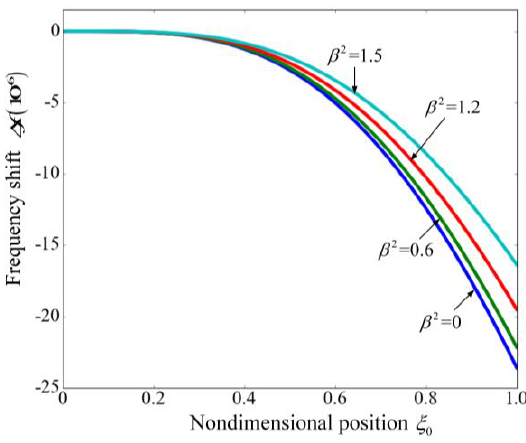
Figure 10. The frequency shift of the fundamental mode as a function of the position of the particle for different nondimensional voltages.